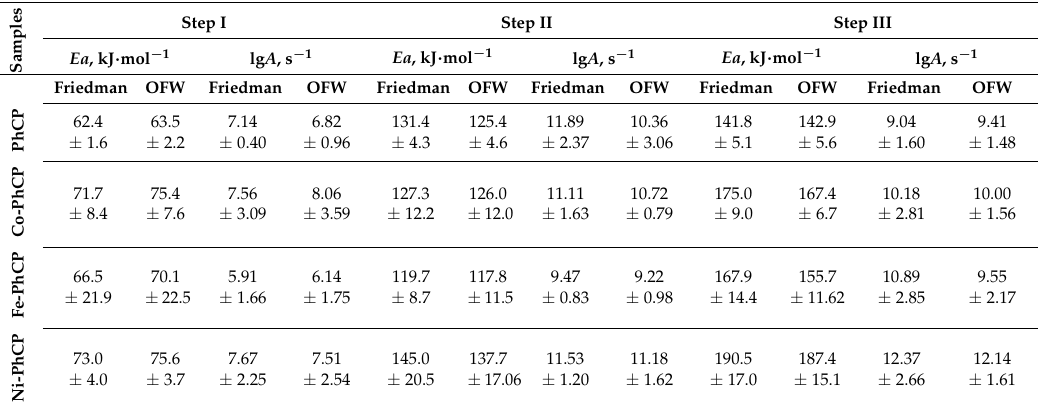
Table 2. The kinetics parameters obtained by Friedman and OFW methods for PhCP and all metal forms (Co-PhCP, Fe-PhCP, and Ni-PhCP).